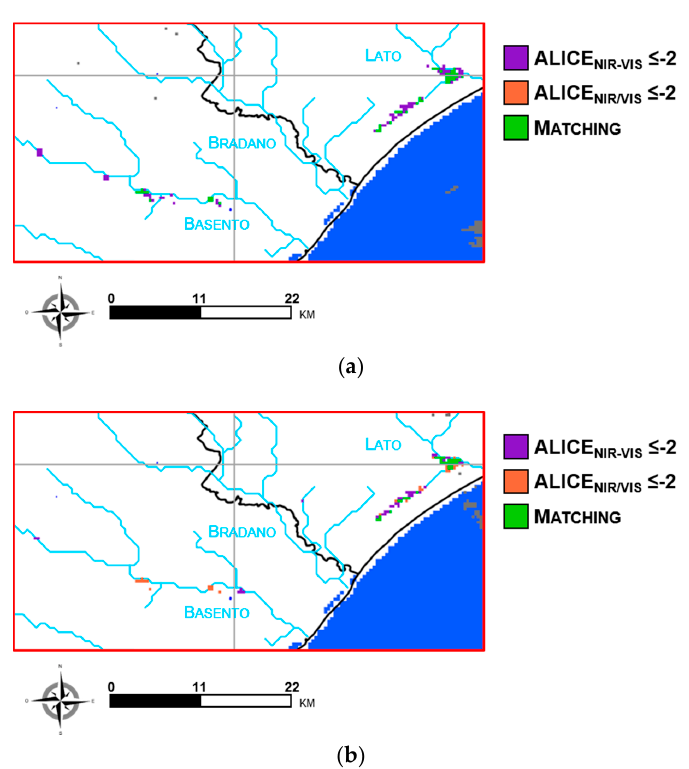
Figure 4. Anomalous pixels detected within the red box shown in Figure 1 by MODIS-based RST-FLOOD on ( a ) 4 December 2013 at 12:25 GMT and ( b ) 5 December 2013 at 11:30 GMT using ALICE NIR-VIS (violet pixels) and ALICE NIR/VIS (orange pixels). In green, the pixels detected as anomalous by both indices are highlighted.